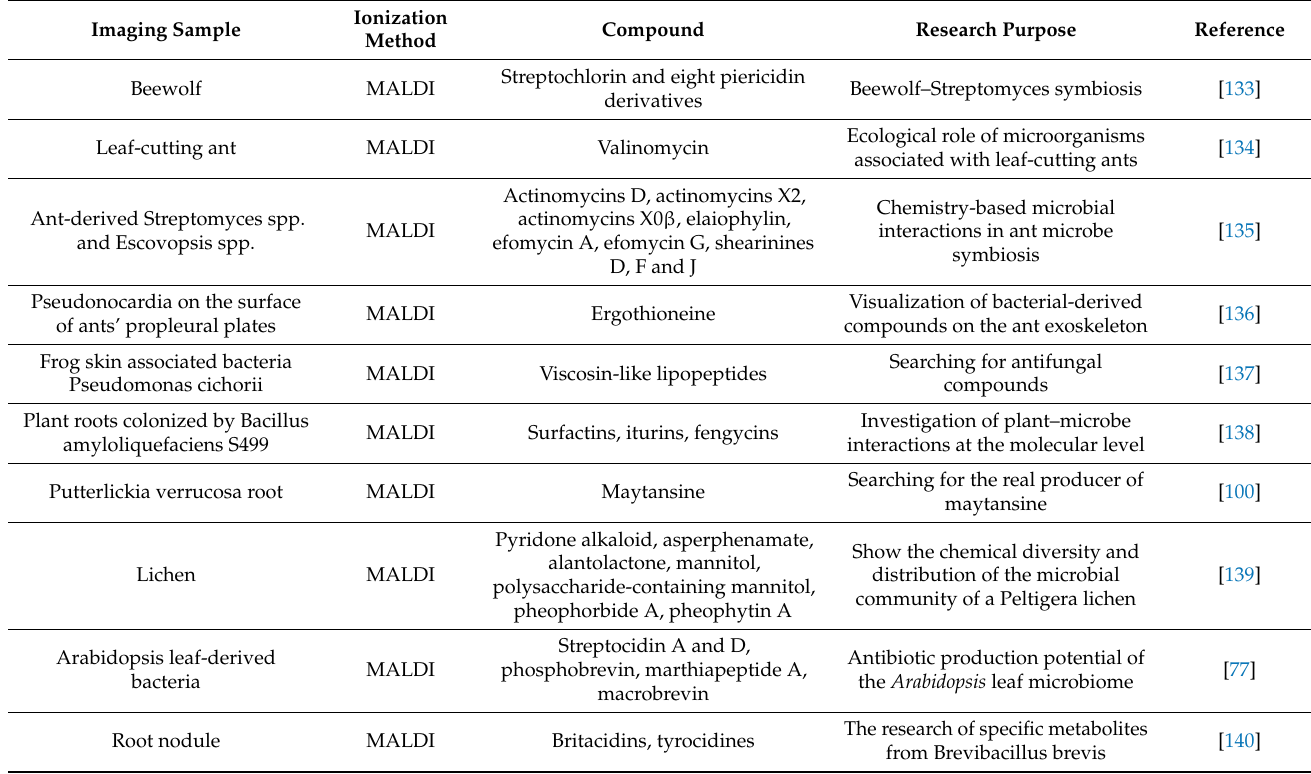
Table 6. MSI application in the research of complex microbial communities or